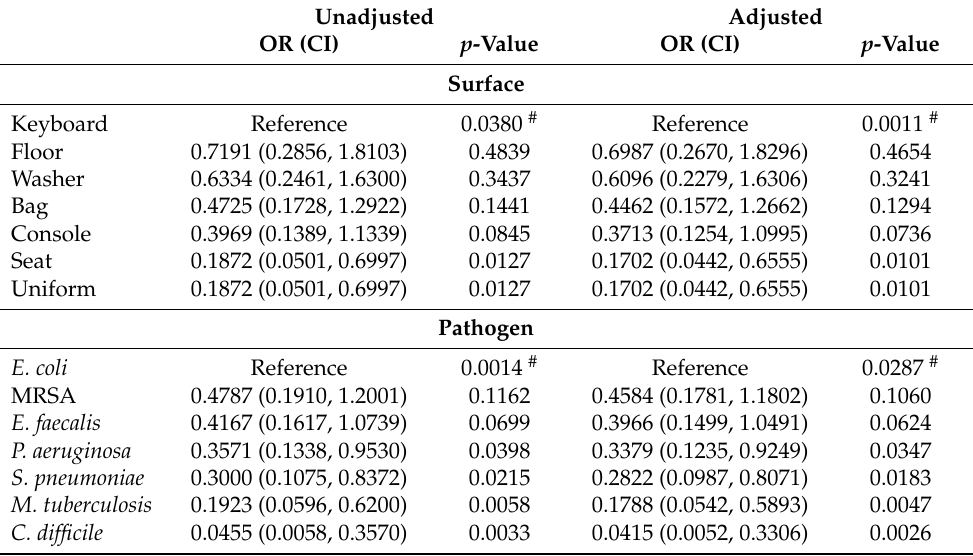
Table 7. Logistic regression models of surface contamination and bacteria type at both FD. The unadjusted columns are for models with just the single factor (either surface or pathogen) and the adjusted columns are for a model with both included. OR = odds ratio, CI = confidence interval, and # = likelihood ratio test of the overall factor in the